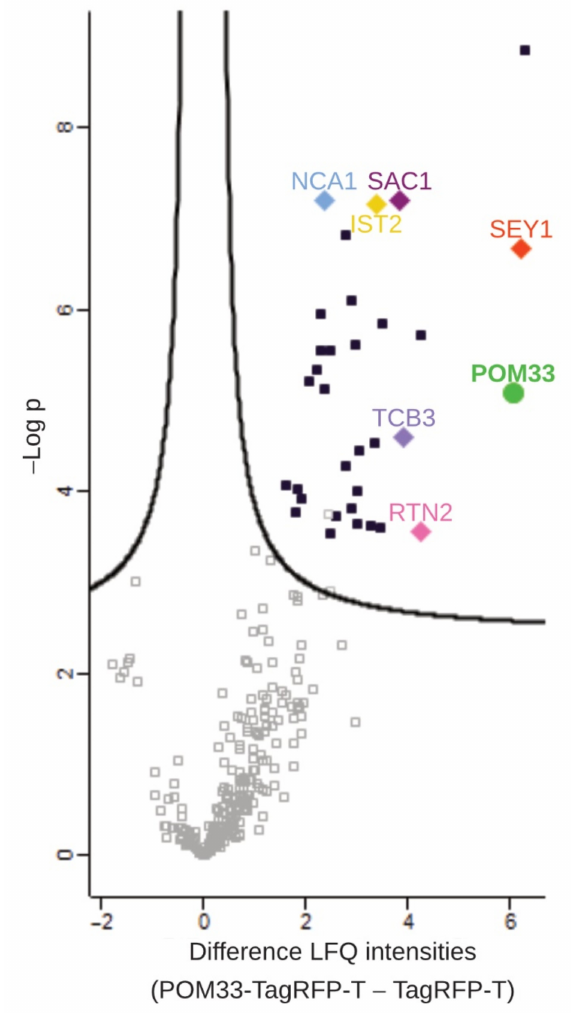
Figure 5. Volcano plot of putative interacting proteins from POM33-TagRFP-T pulldowns. For the pulldowns, in the first experiment three biological replicates of ∆ pom33::pom33-TagRFP-T ect and wt::TagRFP-T ect as control and for the second experiment three biological plus one technical replicate each of the sample and control strain were grown in liquid BMM media over 3 days at 27 ◦ C under continuous light. Protein extracts of the strains were subjected to TagRFP-T-trap pulldown, trypsin digested and resulting peptides were analyzed by LC/MS. The result of two independent experiments is shown. In the volcano plot, the difference of LFQ intensities of POM33-TagRFPT in comparison to free TagRFP-T is plotted on the x-axis versus -Log p -values on the y-axis using a false discovery rate of 0.01 and an S0 of 0.1. The cutoff curve indicates proteins that were significantly enriched with POM33-TagRFP-T. Missing values were replaced four times with imputed values to get reliable interaction candidates. Proteins that were significant in all four repetitions are visible in the upper right part and are marked by dark blue squares (see also Table S4 in Supplementary Materials). They include NCA1 (light blue diamond), RTN2 (pink diamond), SEY1 (red diamond), TCB3 (purple diamond), IST2 (yellow diamond) and SAC1 (magenta diamond) as putative POM33 (neon green circle) interaction